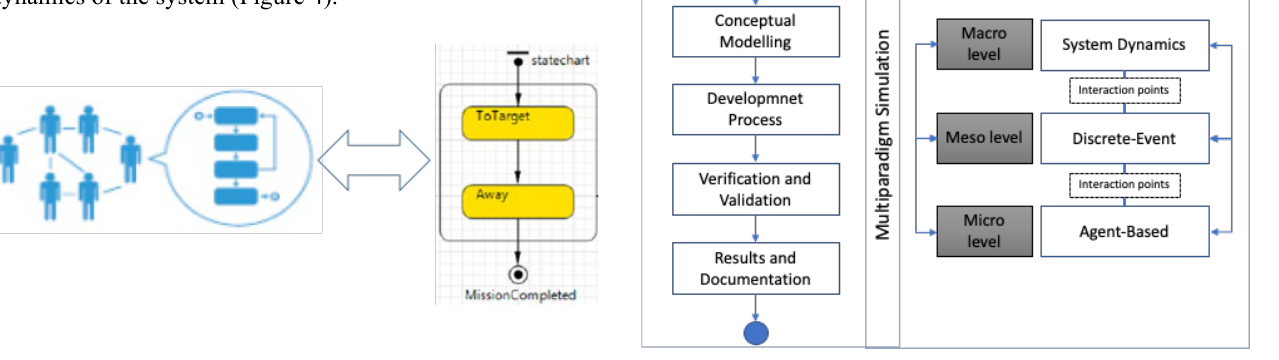
Figure 5. Multiparadigm Simulation